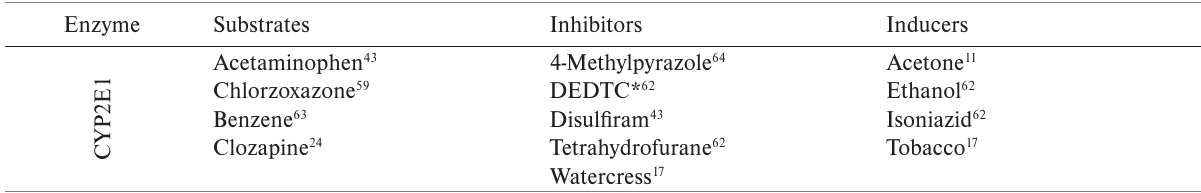
Table 2. Examples of substrates, inhibitors and inducers of the human CYP2E1 enzyme. Enzyme Substrates Inhibitors Inducers Acetaminophen 1 E 2 P Y C